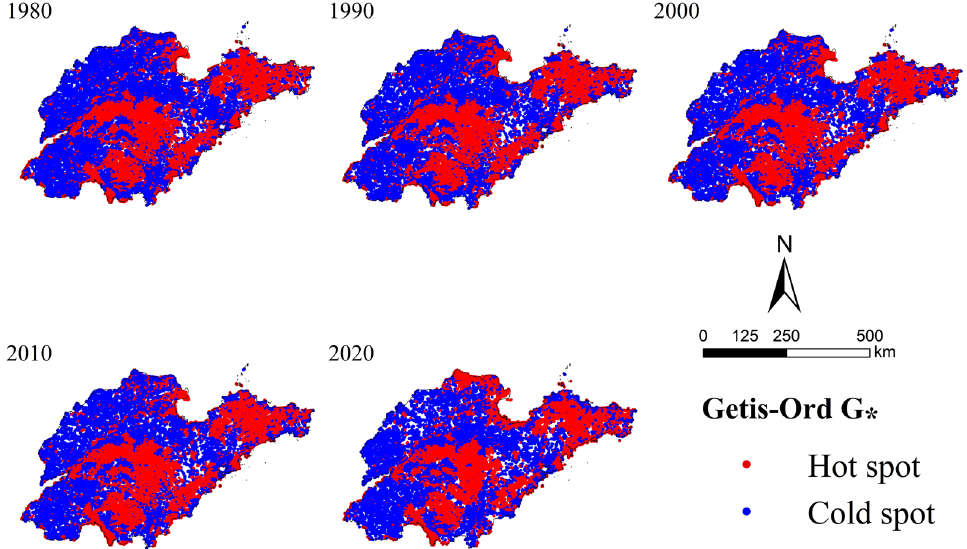
Figure 7. Distribution map of hot and cold spots of habitat quality in Shandong Province from 1980 to